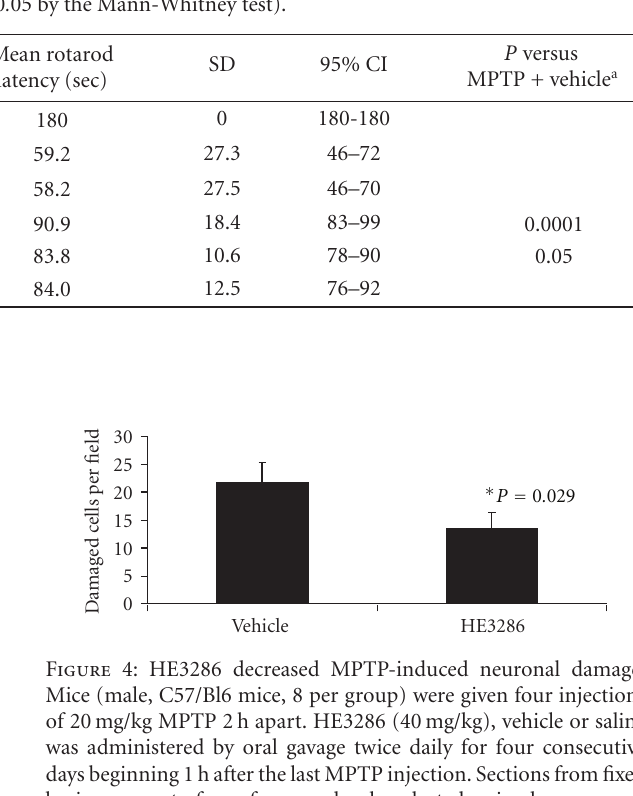
Table 1: ANOVA showed a significant e ff ect overall (Kruskal-Wallis, P = 0 . 0003). Dunn’s post hoc test indicated significance for MPTP + HE3286 and MPTP +L-DOPA compared to MPTP + vehicle, P < 0 . 0001 and P < 0 . 05, respectively. There was no improvement with